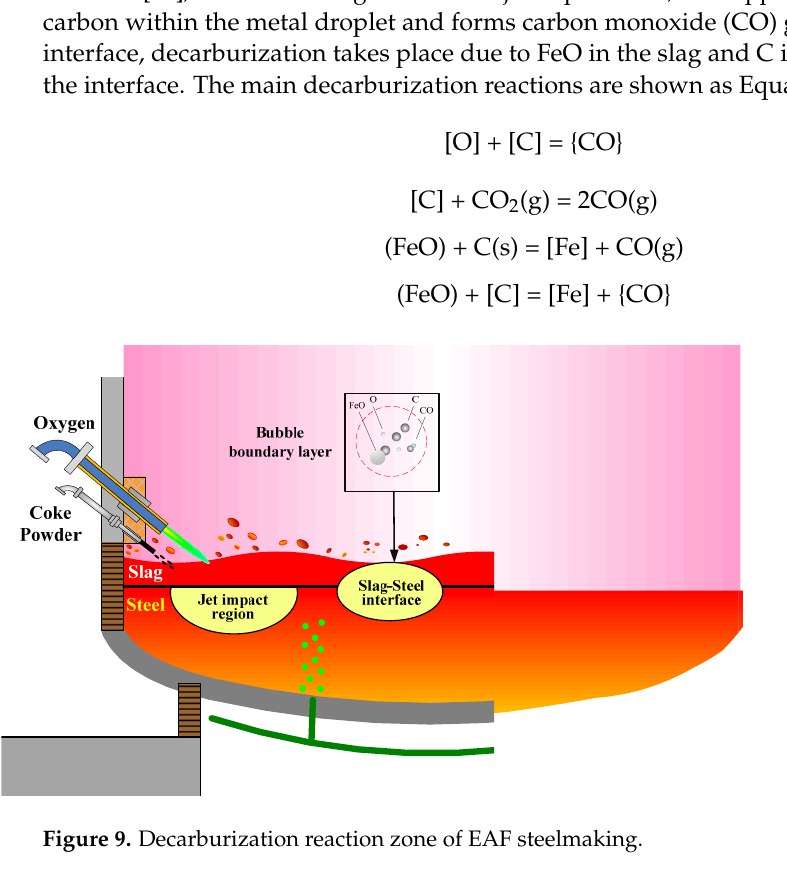
Figure 9. Decarburization reaction zone of EAF steelmaking.